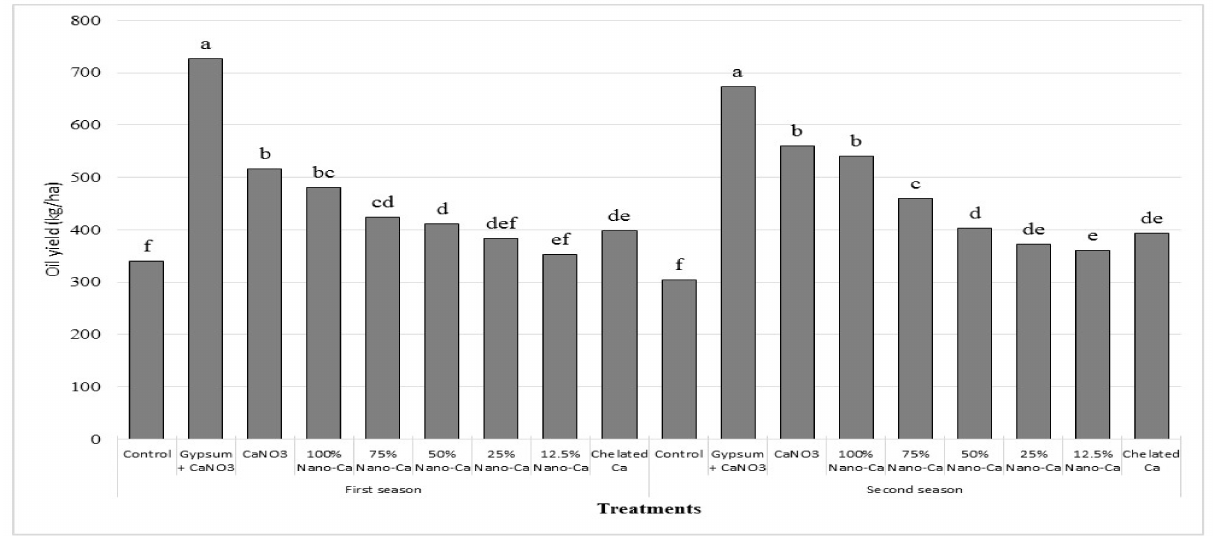
Figure 3. Effect of conventional calcium and nano calcium forms on oil yield (kg ha − 1 ) in peanuts during the two seasons of 2015 and 2016 under sandy soil conditions. Columns labeled with different letters are significantly different at p ≤